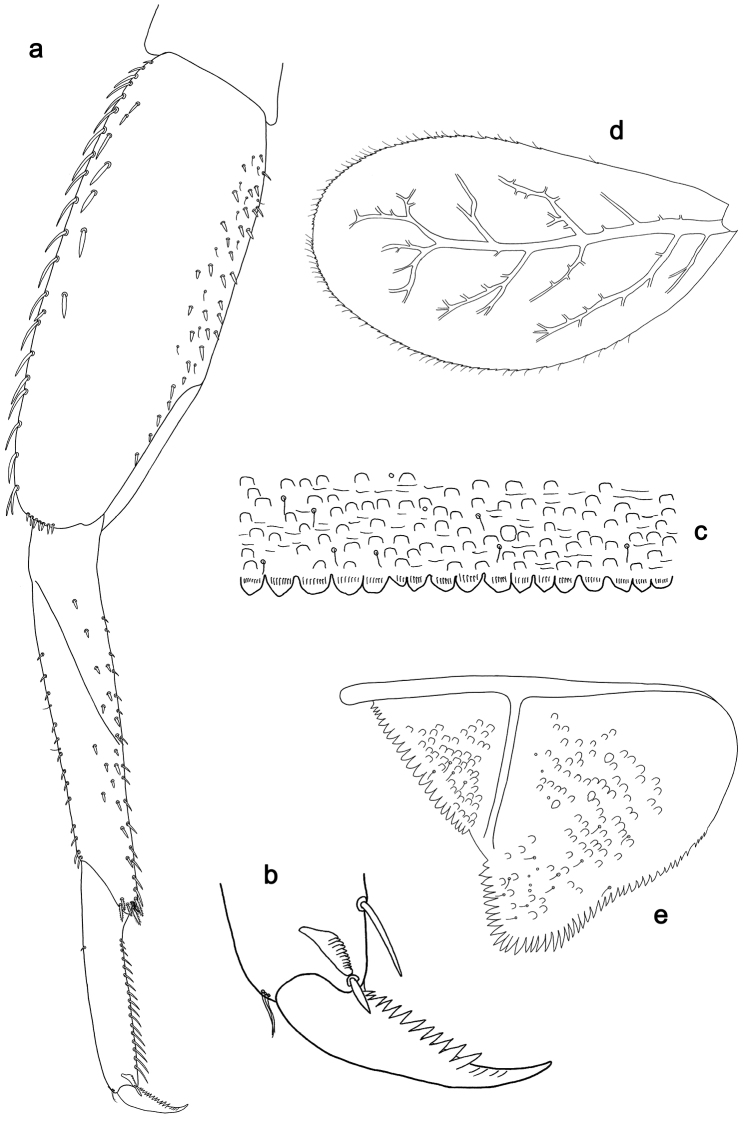
Labiobaetismichaeli sp. n., larva morphology: aForelegb Fore claw cTergum IV d Gill IV eParaproct.